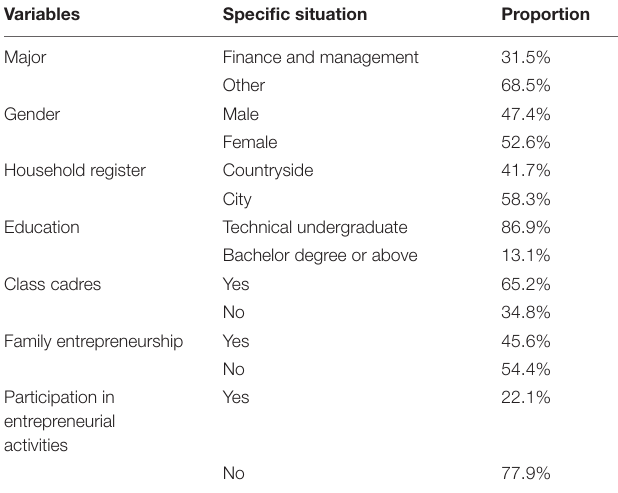
TABLE 3 | Sample statistics.